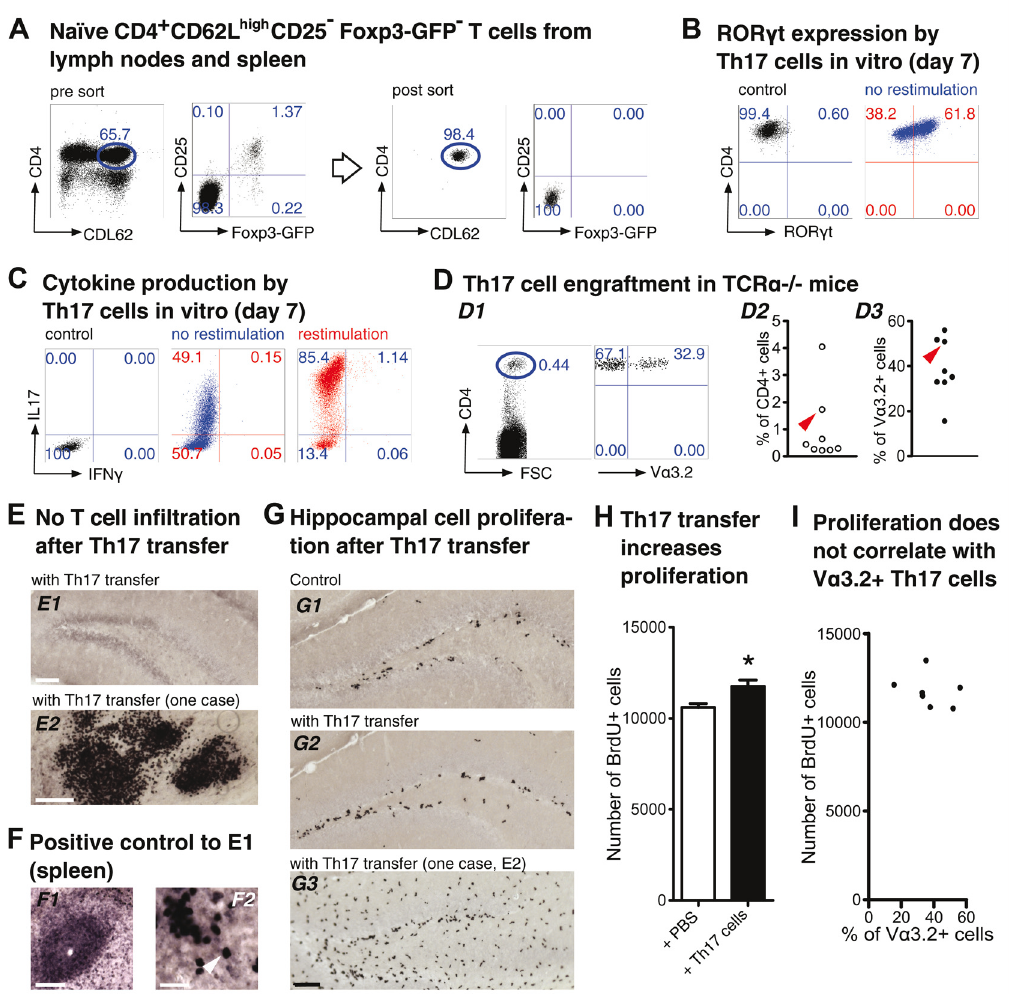
Figure 2. Th17-polarized CD4 + T cells are sufficient to promote hippocampal precursor cell proliferation in adult TCR α –/– mice. ( A – C ) Th17 polarization in vitro . ( A ) Flow cytometry of encephalitogenic CD4 + T cells. Dot plots show pre-sort (left) and post-sort (right) analysis of naïve T cells (CD4 + CD62L high CD25 − Foxp3 GFP− ) from pooled spleen and lymph nodes of 2D2 x Foxp3 GFP mice. FACS-purified T cell populations were cultured under Th17-polarizing conditions, as described in the Methods section. On day 7, efficiency of Th17 cell differentiation was confirmed by intracellular flow cytometry of ( B ) the Th17 transcription factor ROR- γ t and ( C ) the Th17 and Th1 signature cytokines IL-17 and IFN- γ , respectively. ( D – I ) Impact of adoptive Th17 cell transfer on hippocampal precursor cell proliferation in TCR α −/− mice. ( D ) On day 7, 4 × 10 6 total cells from Th17 polarization cultures were injected i.v. into adult TCR α −/− mice. (D1) Dot plots show representative flow cytometry of CD4 + T cells in peripheral blood of recipient mice that express the V α 3.2 subunit of the transgenic 2D2 TCR, two weeks after adoptive transfer. (D2) and (D3) Graphs show composite percentages of total CD4 + T cells (D2) and MOG -reactive V α 3.2 + T cells among gated CD4 + T 35-55 cell populations (D3) from peripheral blood of recipient mice. The arrowheads in (D2) and (D3) highlight an individual mouse that exhibited immune cell infiltrations in the brain (see below). Numbers in dot plots in ( A – D ) indicate the percentage of cells in the respective quadrant or gate. ( E , F ) Anti-CD3 immunohistochemistry. ( E ) Immunohistochemistry of the dentate gyrus of TCR α −/− recipient mice for the pan-T cell marker CD3, two weeks after adoptive Th17 cell transfer. Infiltrating CD3 + T cells were found to be below the level of detection in all mice analyzed (E1, scale bar, 100 μm), with the exception of an individual recipient mouse that exhibited CD3 + T cell and other immune cell infiltrations in some brain areas, including the hippocampus (E2, scale bar, 100 μm). ( F ) Anti-CD3 immunohistochemistry of the spleen from wild-type C57BL/6 mice was included as a positive control (F1, scale bar, 100 μm; F2, scale bar, 25 μm). The arrowhead in (F2) indicates an individual CD3 + T cell. ( G , H ) Quantification of hippocampal cell proliferation. ( G ) BrdU immunohistochemistry of the dentate gyrus of TCR α −/− mice, which had been injected with either (G1) PBS or (G2) Th17 cells two weeks earlier, was performed 24 hours after the first of 3 consecutive BrdU injections. (G3) depicts the dentate gyrus of the mouse exhibiting immune cell infiltrations (see E2). Scale bar, 100 μm. ( H ) Quantification of BrdU + cells in the dentate gyrus of TCR α −/− mice injected with either PBS (n = 7) or Th17 cells (n = 7). All numbers are mean ± SEM. t-test, * p < 0.05. ( I ) Scatter diagram to visualize a possible relationship between cell proliferation in the dentate gyrus and the percentage of MOG -reactive V α 3.2 + T cells among CD4 + T cells in the peripheral blood of recipient mice two weeks after adoptive transfer. 35-55 No statistically significant correlation was